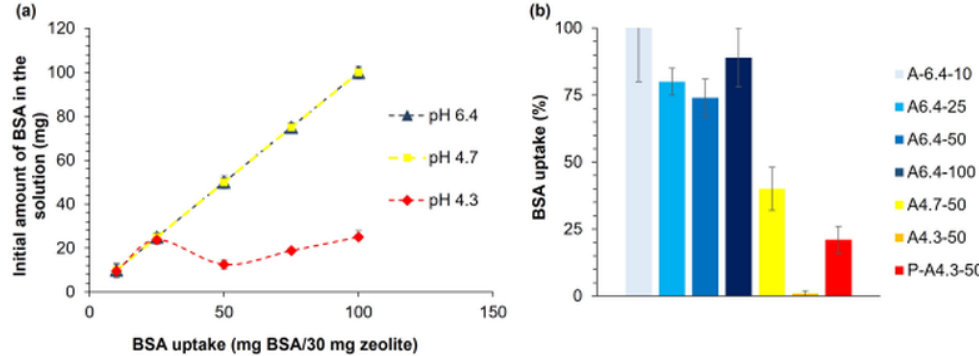
Figure 10. ( a ) BSA uptake as a function of BSA concentration in zeolite at various pH values, ( b ) BSA adsorption efficiency of hydrogel films.